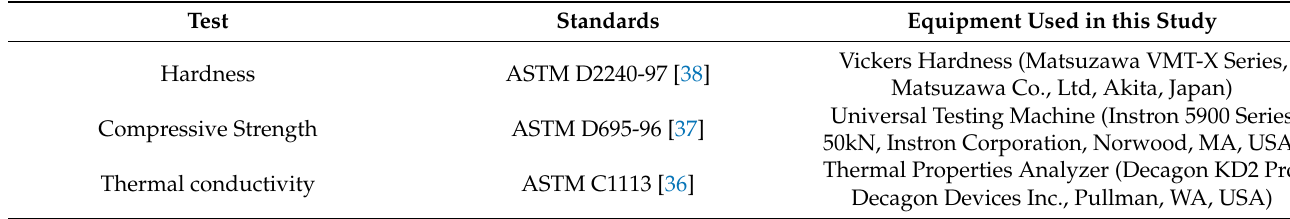
Table 3. Mechanical and thermal properties test of epoxy with metal fillers.